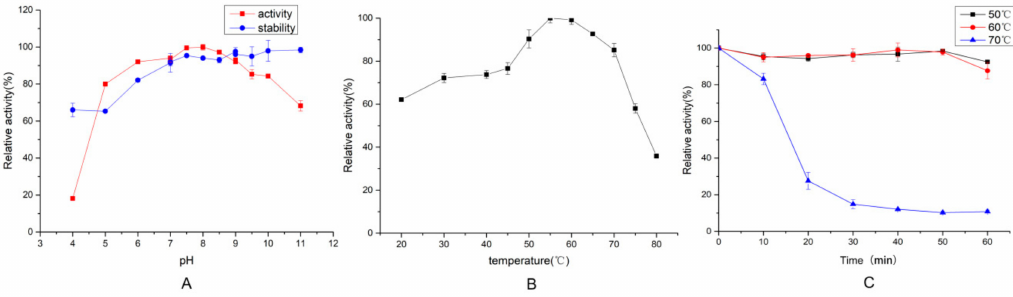
Figure 3. E ff ects of pH ( A ), temperature ( B ) on EH2 activity, and thermal stability of EH2 at 50 ◦ C, 60 ◦ C and 70 ◦ C ( C ). Values are expressed as the mean ± SD ( n =